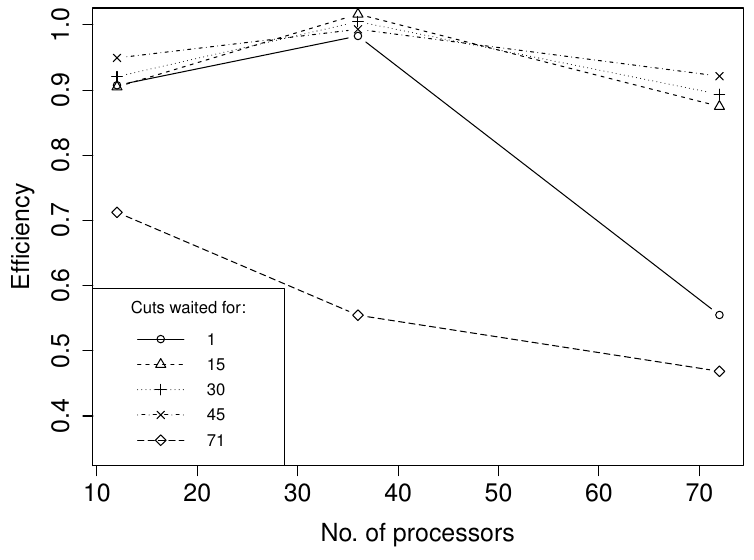
Figure 5. Parallel efficiency as a function of the number of processors for Case 1. Each line corresponds to a separate choice of N W .